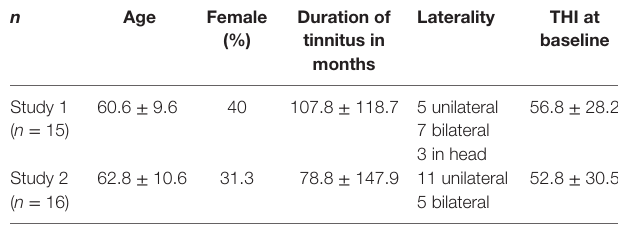
Table 1 | Patient groups, clinical and demographic data (mean ±